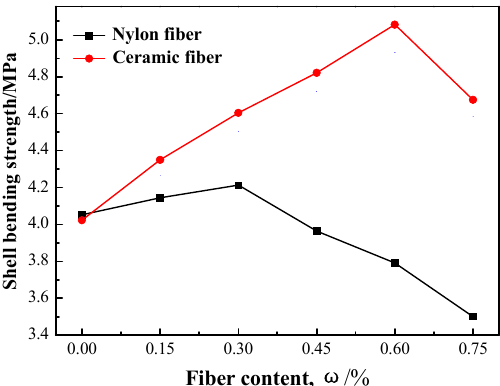
Figure 6. Influence of fiber content on the strength of shell roasting.